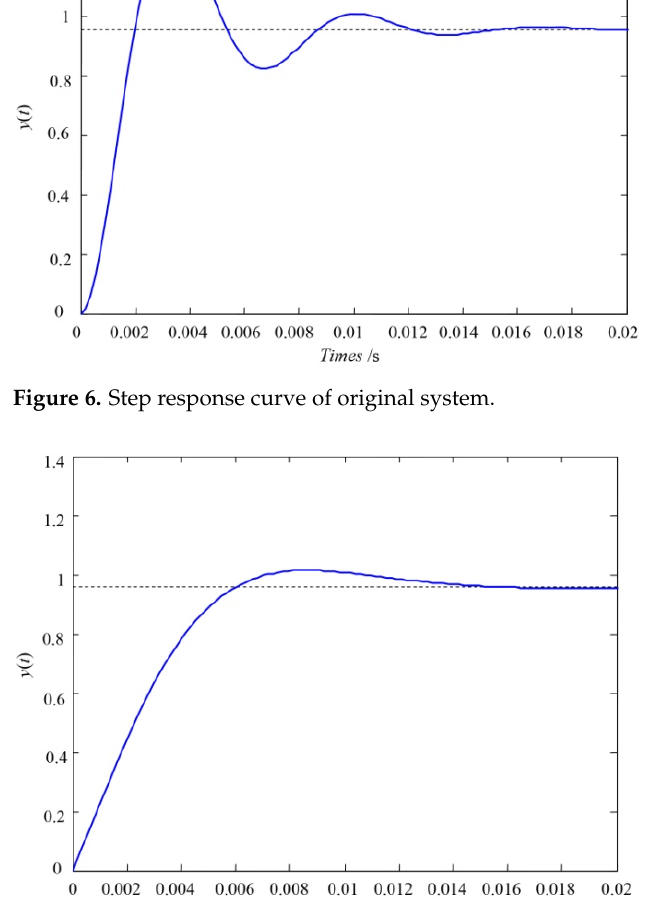
Table 1. Transient response indexes of original system and optimized system.